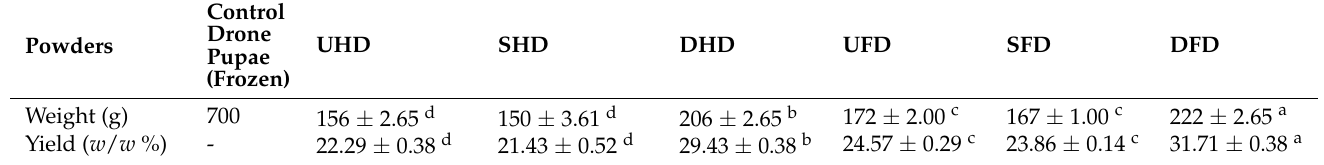
Table 4. Yield results of the drone pupae powders processed using different